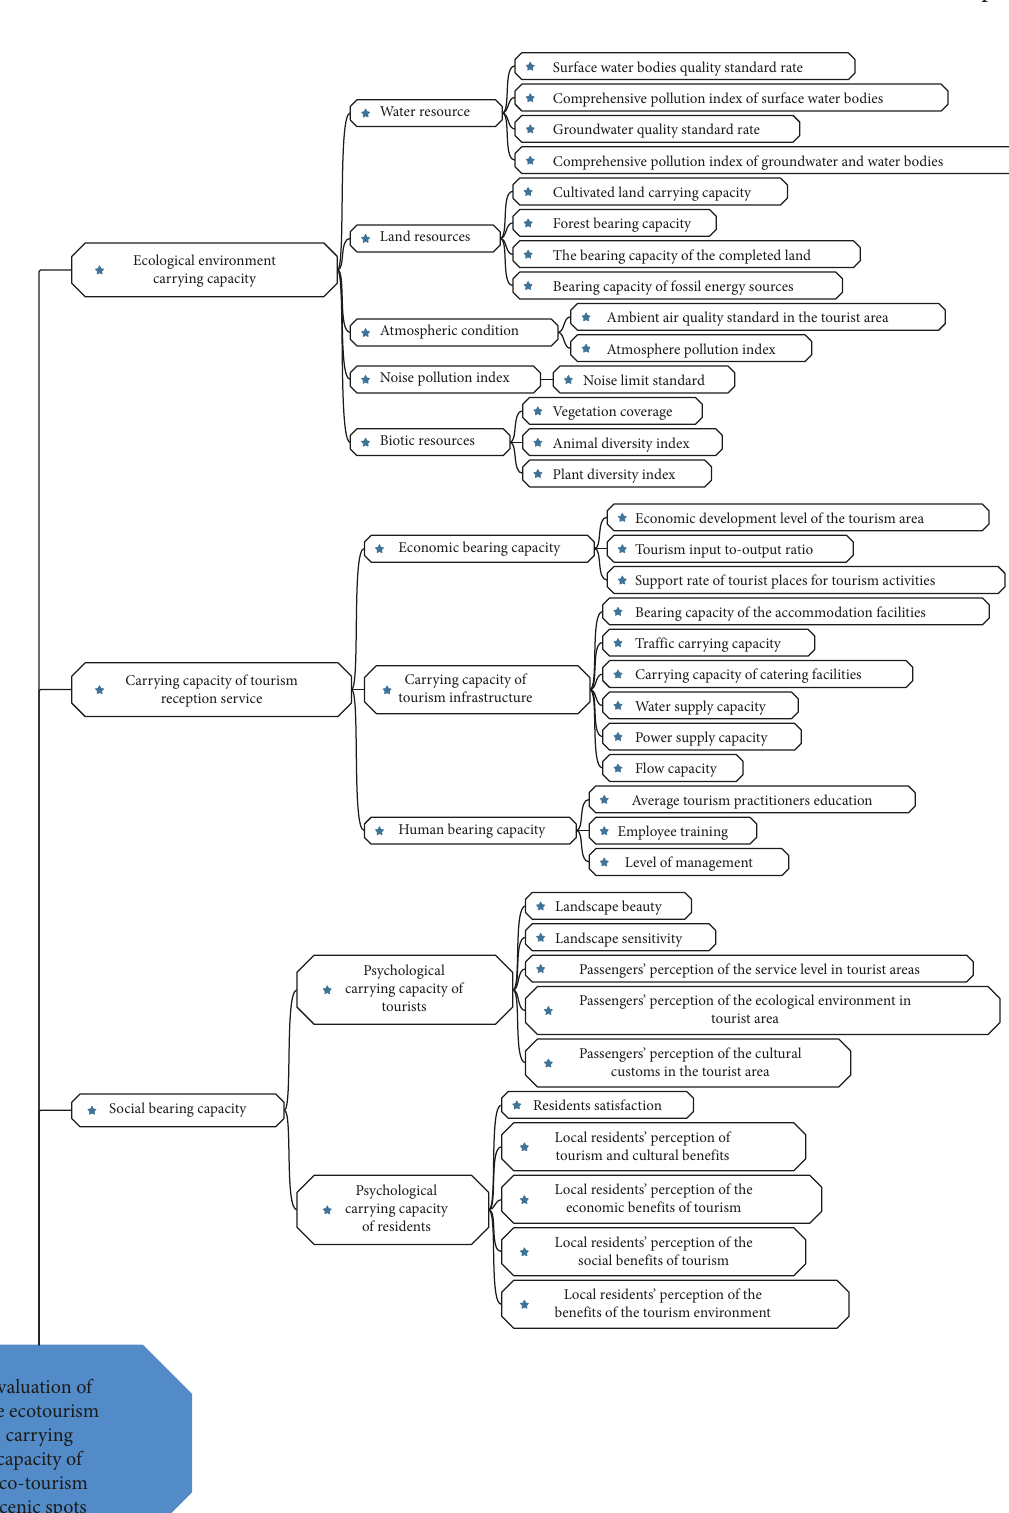
Figure 6: Evaluation index system of ecotourism carrying capacity of tourist